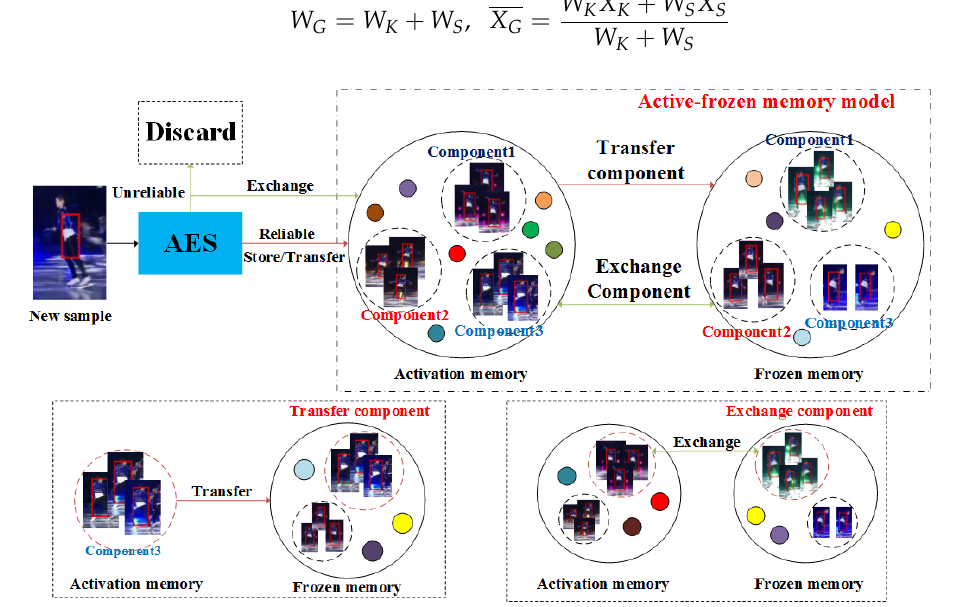
Figure 5. The structure of the active–frozen memory model ( top row ). There are two operations ( below row ), namely transfer component and exchange component. Only reliable tracking results are stored and are otherwise discarded directly. The active–frozen memory model guarantees the diversity and reliability of tracking results in active memory by exchange operations and